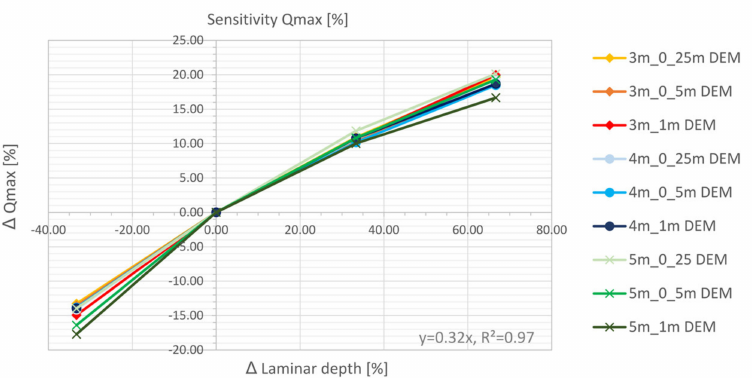
Figure 24. Comparison of the model sensitivity (S-Qmax) for laminar depth and the evaluated mesh and DEM resolutions with the averaged elasticity ratio